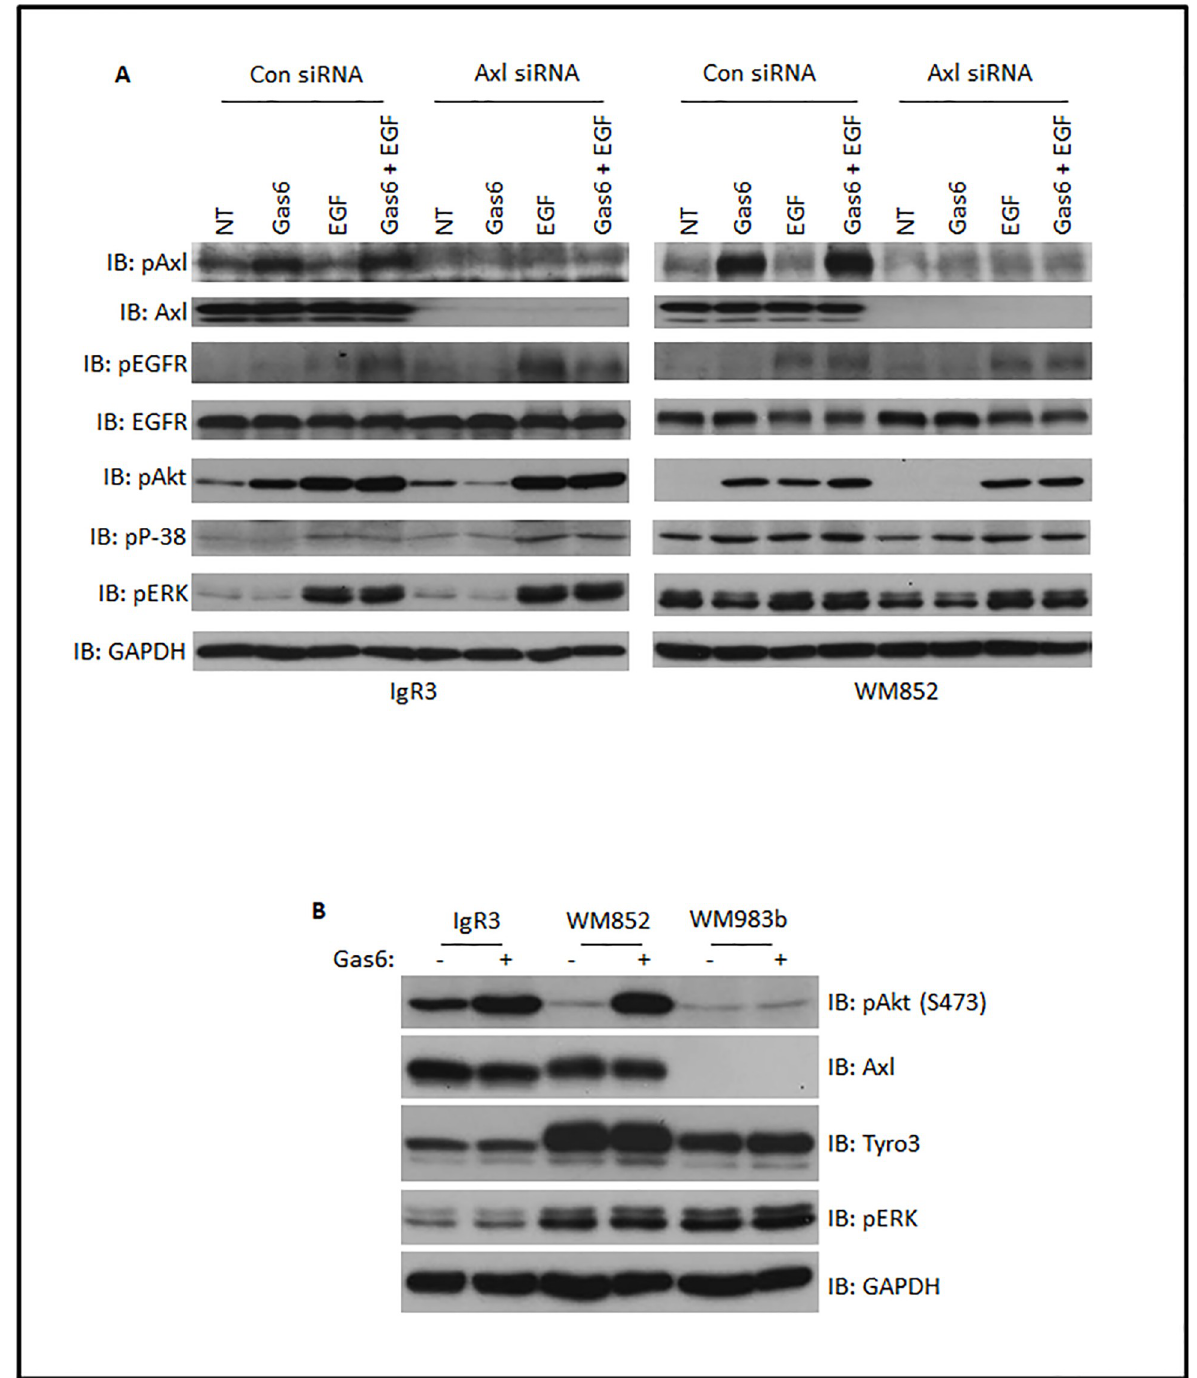
Fig 2. Gas6-mediated activation of Axl in melanoma cells. (A) Indicated melanoma cell lines were transiently transfected with control or Axl siRNA for 2 days prior to starving in quiescence media for 16h. Quiescent cells were then stimulated with indicated factors at the concentrations of 10 nM (EGF) and 200 ng/ml (Gas6) for 10 min followed by lysis in RIPA buffer for immunoblotting using the indicated antibodies. (B) Immunoblotting of indicated proteins extracted from quiescent melanoma cell lines treated with or without 200 ng/ml Gas6 for 10 min. NT: non treatment. Shown are representative blots of three